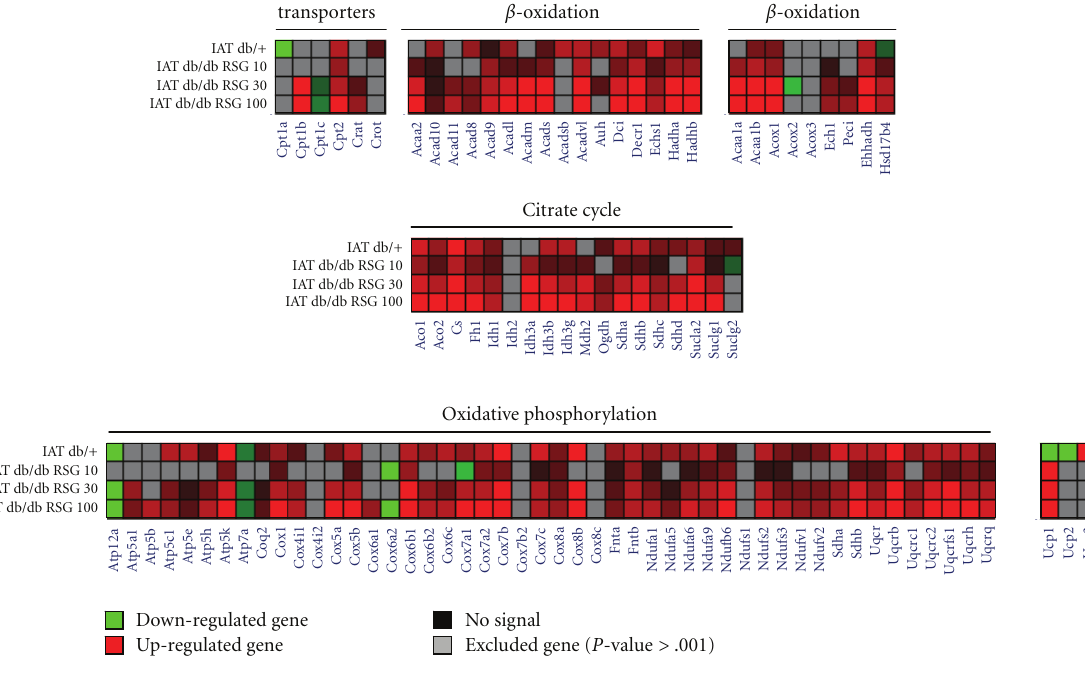
Figure 3: Two-dimensional representation of di ff erentially expressed genes involved in IAT mitochondrial and peroxisomal functions. Ratio for di ff erentially expressed genes in db/+ and RSG-treated db/db versus untreated db/db were plotted. Each coloured box represents di ff erential expression ratio ranging from bright green (lowest) to bright red (highest). Missing value are in grey when P -value ≥ .001. Genes involved in mitochondrial transport of FA, in mitochondrial and peroxisomal β -oxidation and citrate cycle and in oxidative phosphorylation were